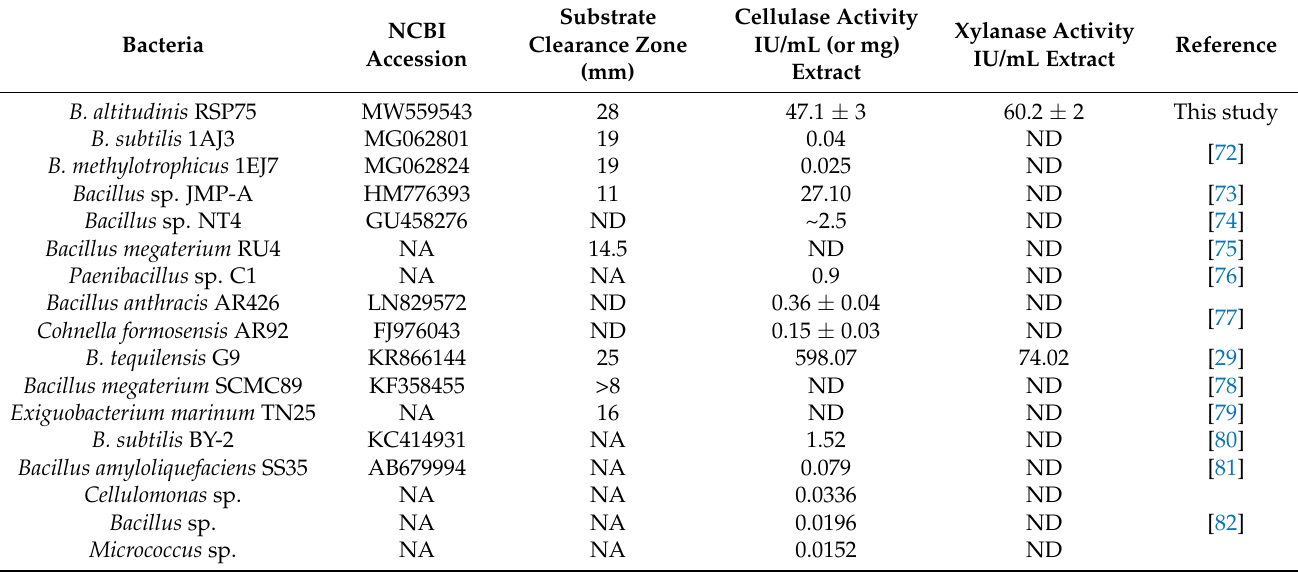
Table 3. The comparison of the enzyme activity of B. altitudinis RSP75 with some previously reported aerobic Gram-positive cellulose-degrading bacterial